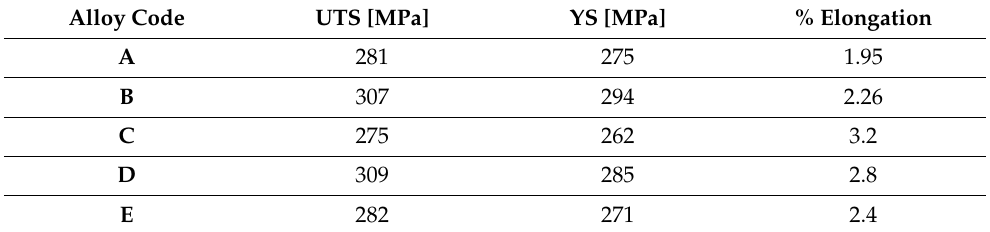
Table 5. Tensile properties of the five alloys following treatment 11 (T6